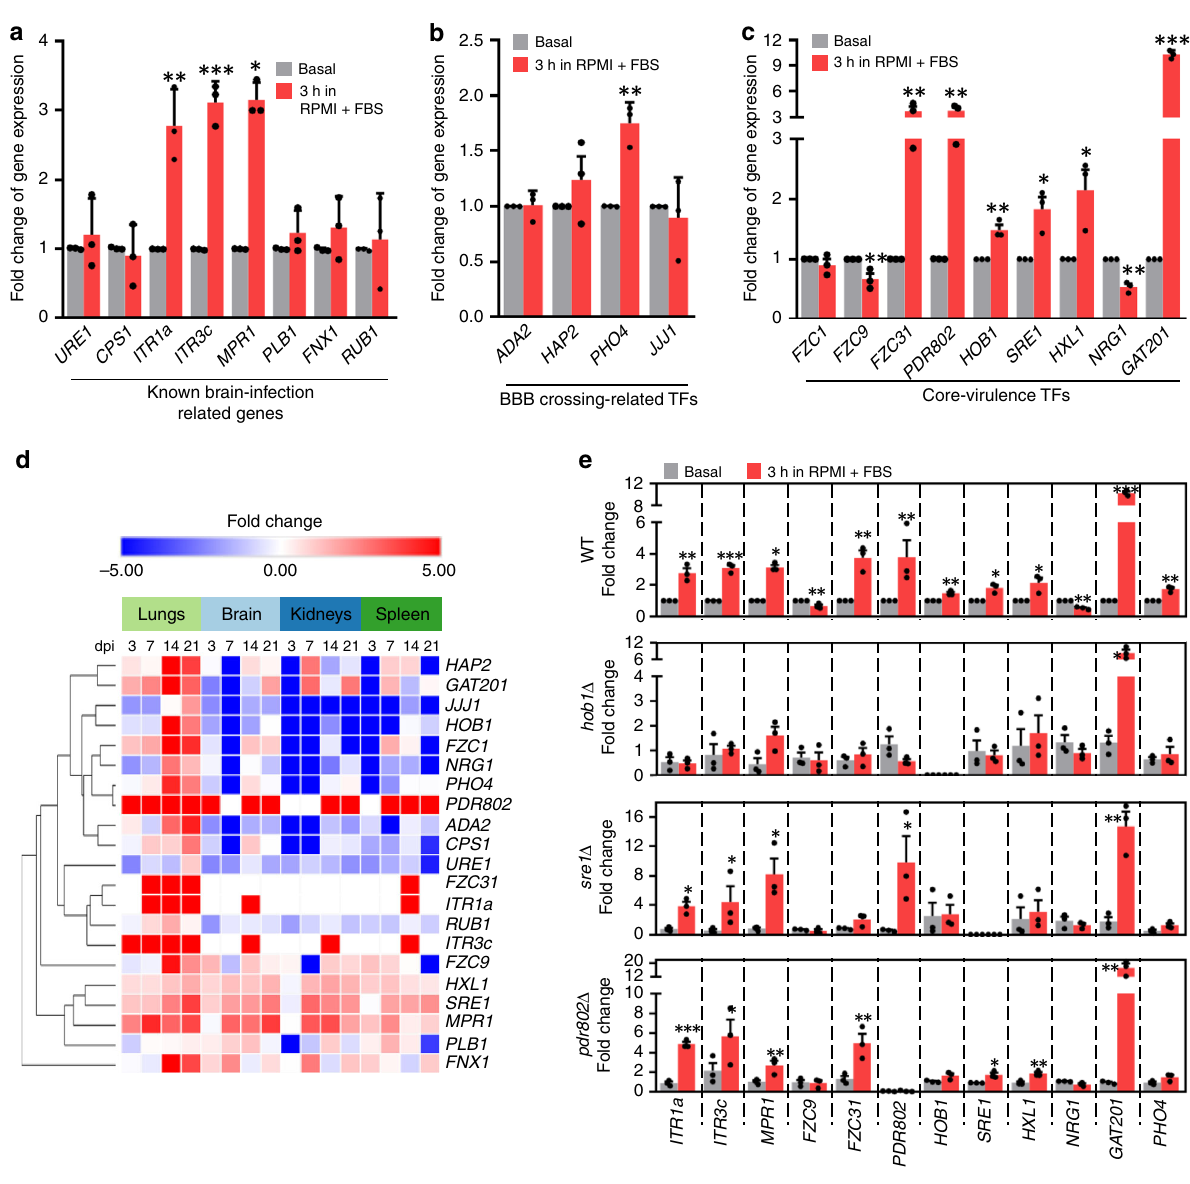
Fig. 5 The homeobox transcription factor Hob1 as a master regulator of brain-infection-related genes in C. neoformans . a – c , e Host-mimic condition (HMC) mediated induction of known brain-infection-related genes ( a ), BBB crossing-related TFs ( b ), and core-virulence TFs ( c ). Expression of each gene was determined by quantitative RT-PCR with cDNA synthesized from total RNA isolated from C. neoformans WT (H99) and mutant ( hob1 Δ , sre1 Δ and pdr802 Δ ) strains that were shifted from basal condition (YPD at 30 °C; control samples; grey bars) to HMC (RPMI with 10% foetal bovine serum at 37 °C under 5% CO 2 ) and incubated for 3 h (red bars). Fold change of gene expression was calculated relative to the basal expression levels of each gene. Data from three independent experiments performed in duplicates are presented as mean values ± SEM. Statistical signi fi cance of difference in gene expression levels between basal and HMC condition (unpaired, n = 3) was determined by two-tailed Student ’ s t test (*, P < 0.05; **, P < 0.001; ***, P < 0.0001). d NanoString heatmap of genes used in ( a - c ) was clustered by using Morpheus. Bold letters indicated the genes whose expression level was induced or reduced under